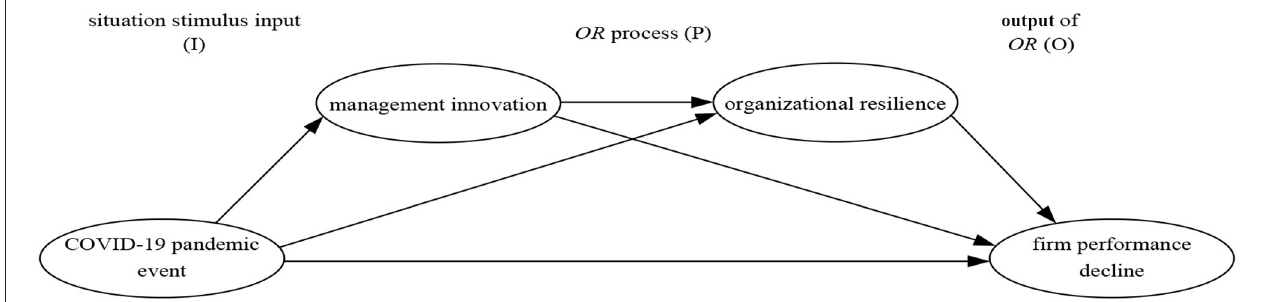
FIGURE 1 | Research model.